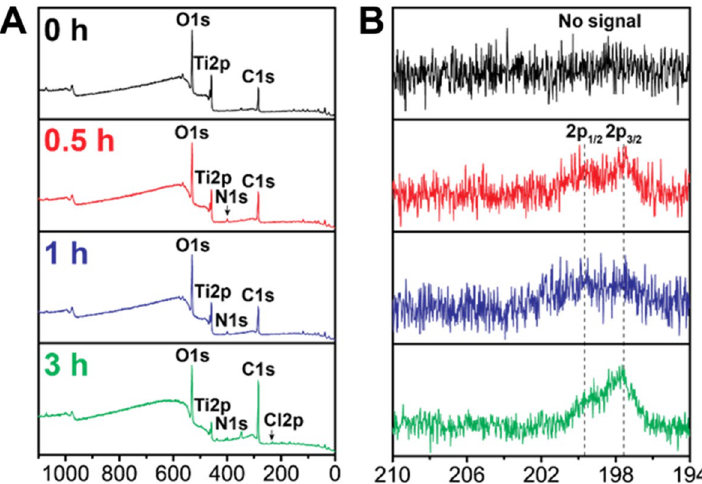
Figure 3. Detection of Teic coating on the Ti surface. X-Ray Photoelectron Spectroscopy (XPS) analysis of ( A ) survey peaks and ( B ). high-resolution Cl2p peaks of Teic-treated Ti discs with different immersion times: 0, 0.5, 1, and 3 h. It is clear that Teic adsorption occurs within 30 min of Teic exposure.